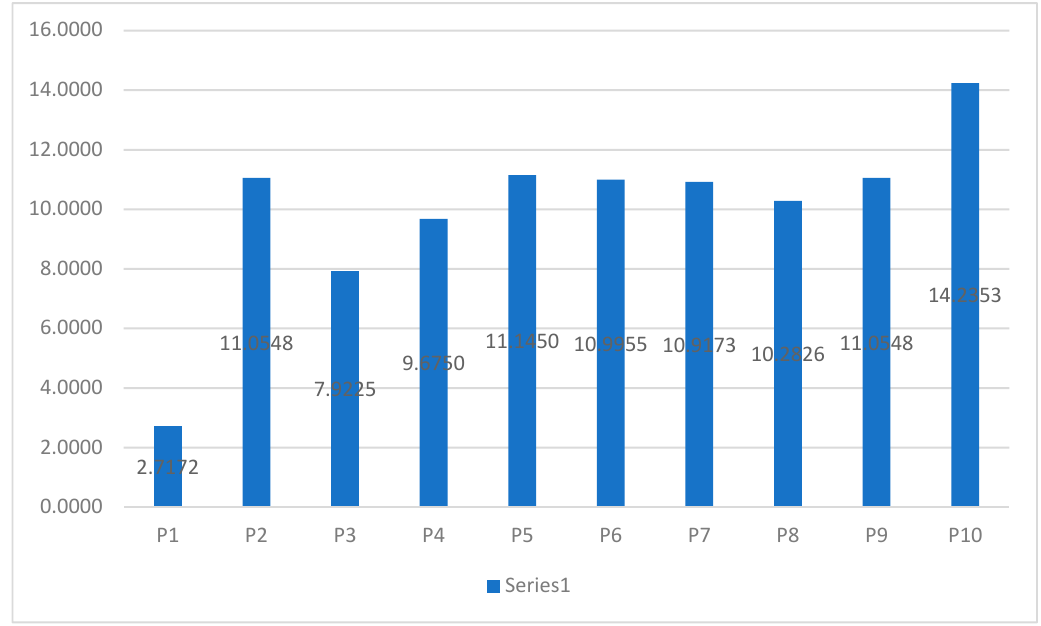
Table 7. A Group AHP Decision Matrix.